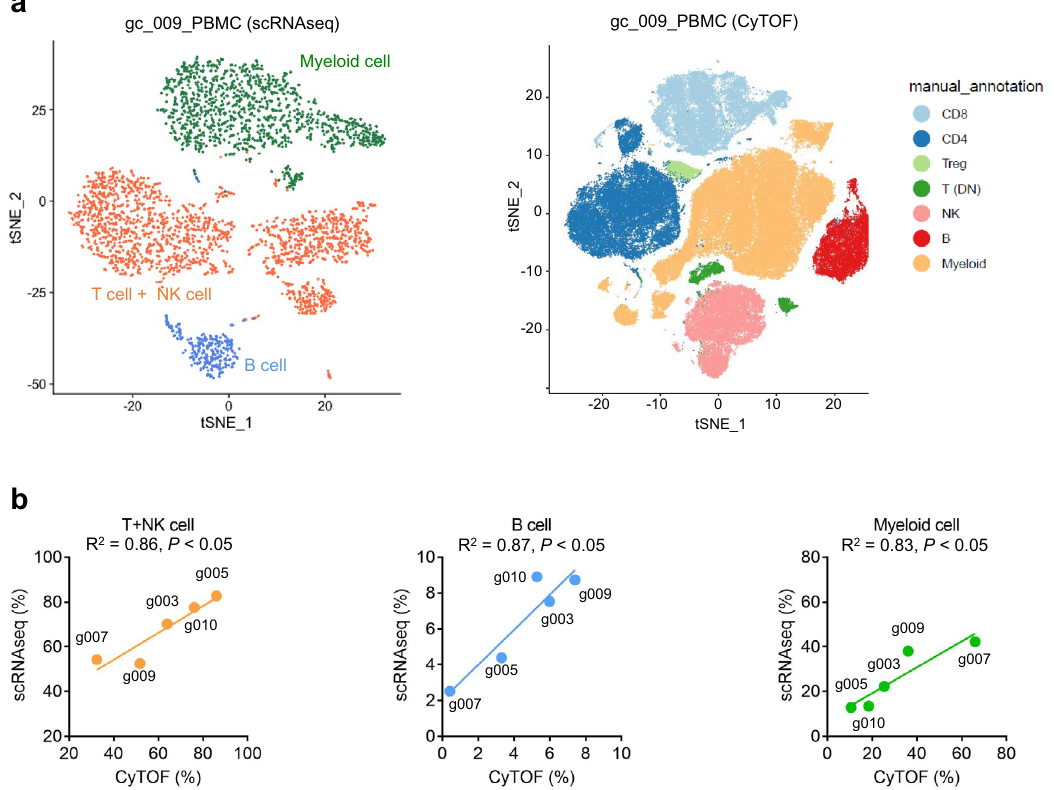
Figure 2. Comparison between scRNA-seq data using a droplet-based system and CyTOF data showed good concordances in PBMCs. ( a ) t-SNE plot based on scRNA-seq (left) and t-SNE plot based on CyTOF (right) of PBMCs. The same samples were divided into two groups for each method. After clustering, cells are annotated using representative genes or molecules in Table S3 (for CyTOF) and Table S5 (for scRNA-seq). ( b ). Comparison between CyTOF data (x-axis) and scRNA-seq data (y-axis). %T + NK cell, %B cell and %Myeloid cell in CD45 + immune cells are